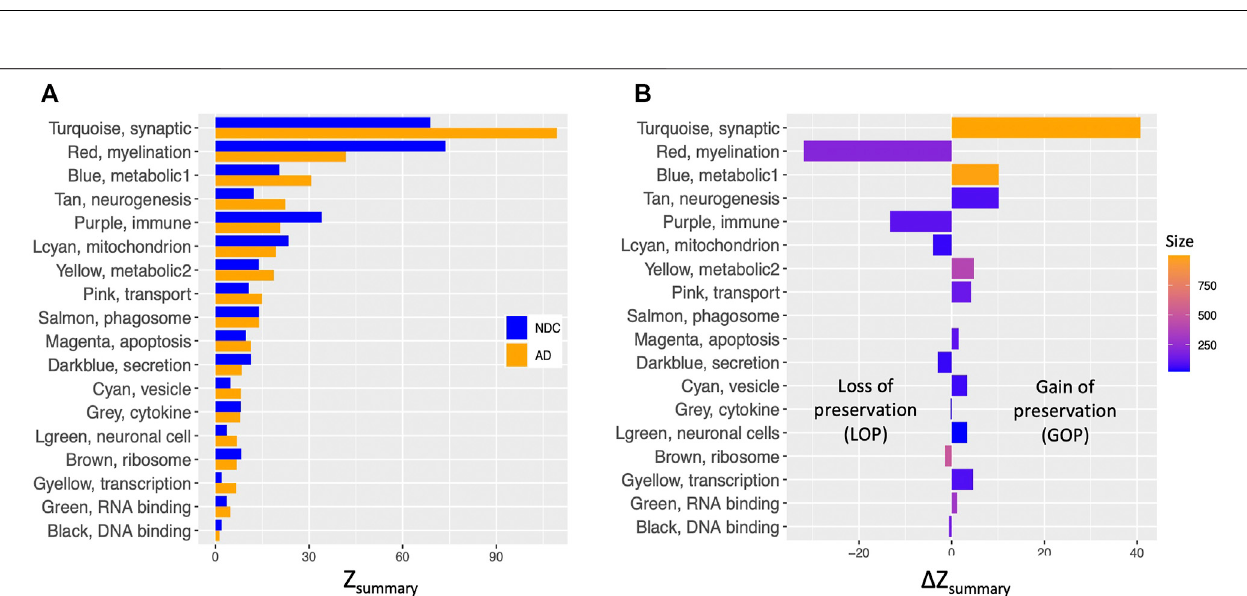
FIGURE 4 | Comparison of density and connectivity-based preservation of TLE modules in AD and NDC networks. (A) The overall signi fi cance of the observed preservation statistics was assessed for each TLE module ( Y axis) by combining density and connectivity-based preservation Z statistics into a single overall measure of preservation de fi ned as Z summary shown in pairs on X axis for NDC (blue bars) and AD (orange bars) networks. (B) The arithmetic difference of preservation Z summary values, Δ Z summary in X axis between NDC and AD networks for each of the TLE modules in Y axis. Positive Δ Z summary indicates gain of preservation (GOP, more preserved) and negative Δ Z summary indicates loss of preservation (LOP, less preserved) of the given TLE module in the AD network compared to NDC network.